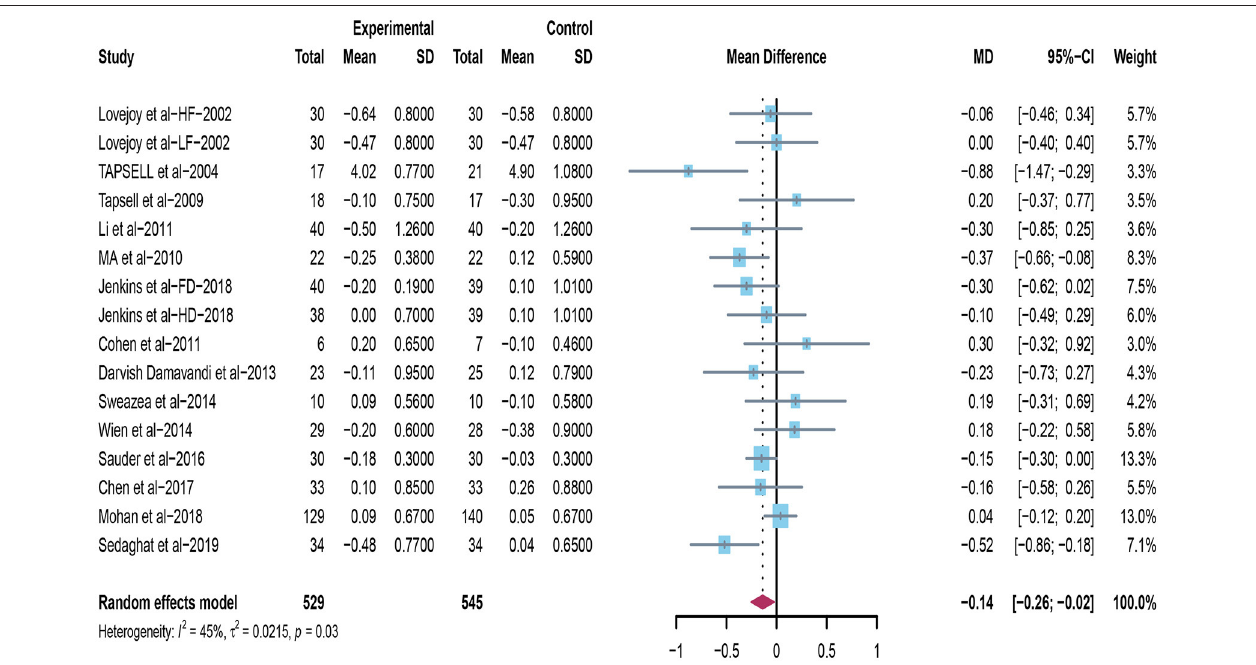
of peanuts and tree nuts consumption on LDL-C, HDL-C,